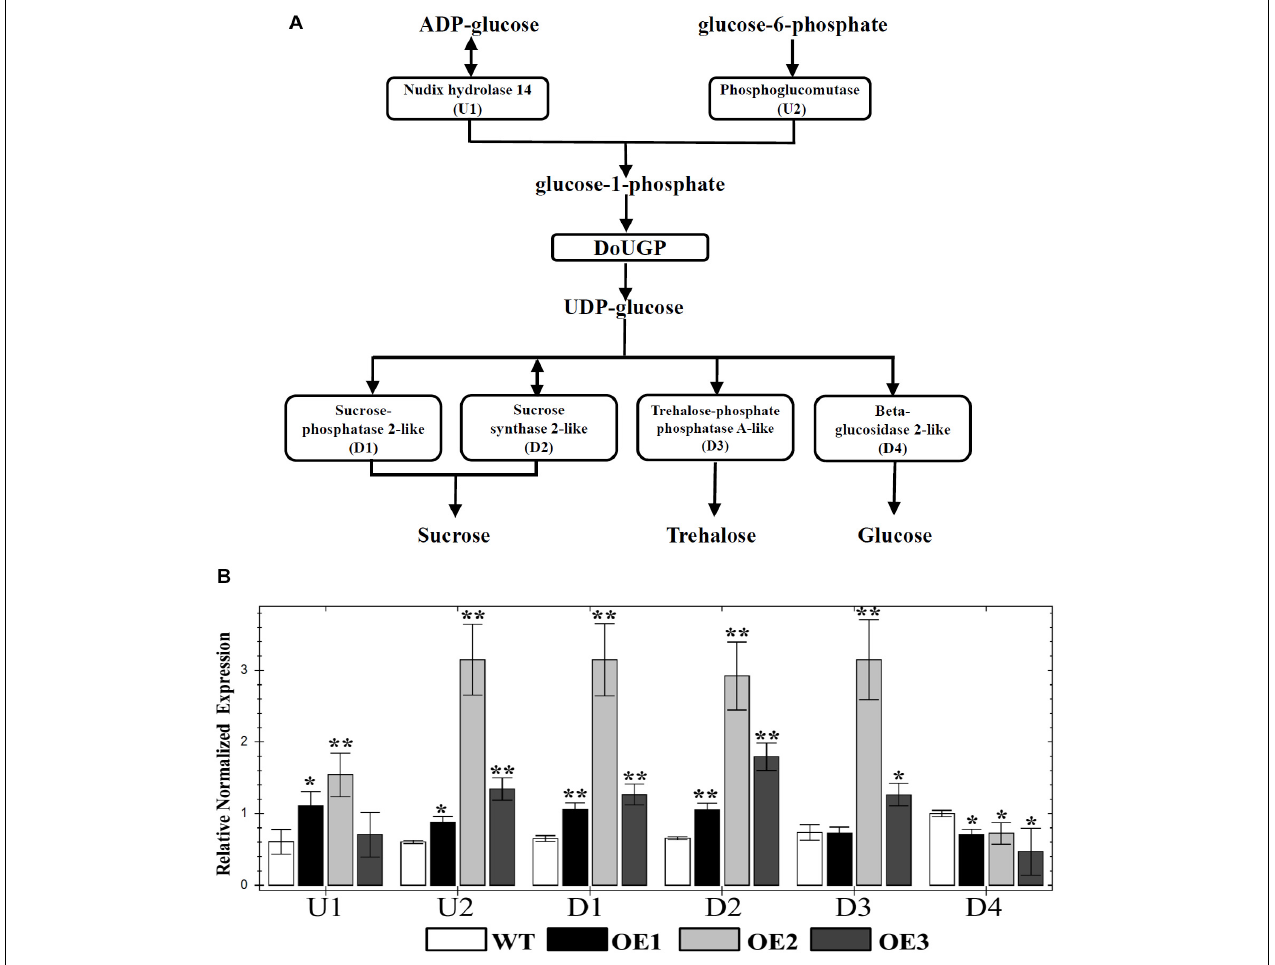
FIGURE 3 | Quantitative real-time (qRT)-PCR analysis of up/downstream genes of DoUGP in starch and sucrose metabolism pathway. (A) Starch and sucrose metabolism pathway and critical genes. (B) Relative expression levels of up/downstream genes of DoUGP in leaves of transgenic and wild-type plants. Results are presented as mean ± standard error calculated from three biological replicates. Asterisks indicate the statistically significant differences (Student’s t -test, p < 0.05).